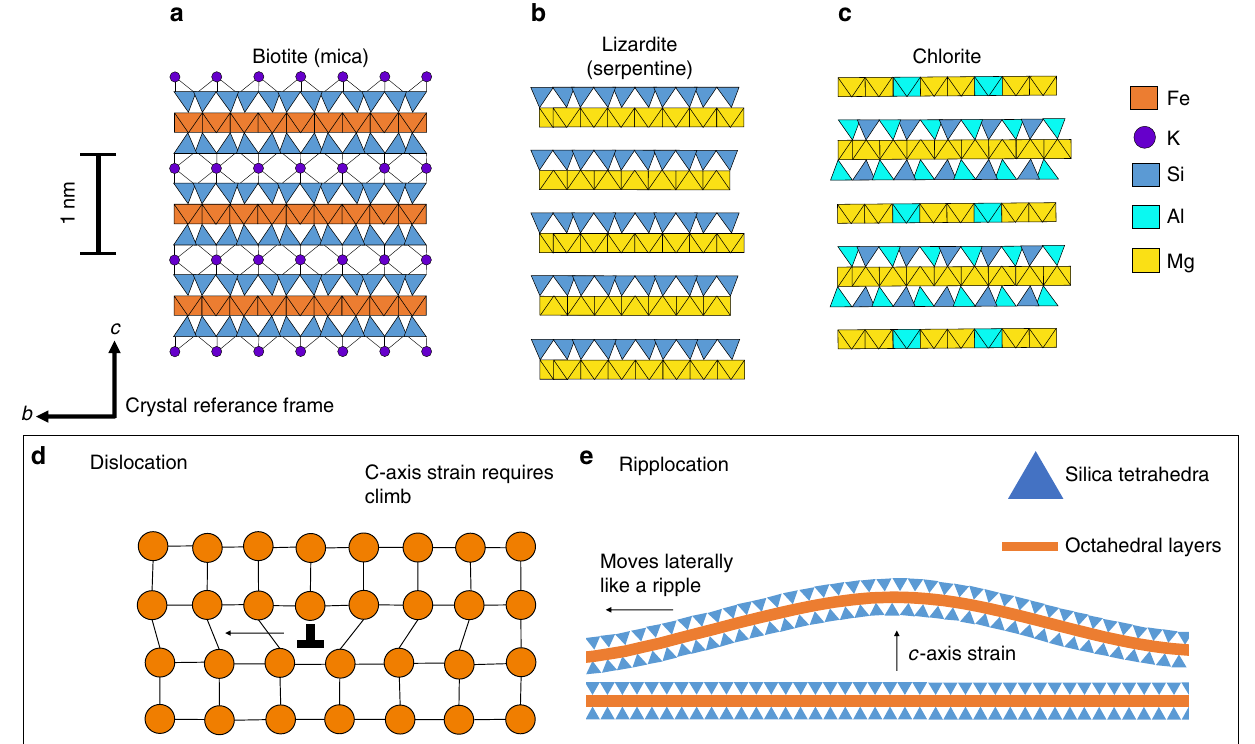
Fig. 1 Phyllosilicate structures and ripplocation morphology. a – c Atomic structure models of some common phyllosilicates with valences identi fi ed by polygons. The indices of these polygons are occupied by O atoms or OH groups. a Biotite, like other micas, requires an interlayer cation (I) to balance the overall negative charge of its tetrahedral (T) and octahedral (M) layers. In the cases of biotite and muscovite this cation is predominantly K, whereas in paragonite, and others, it is Na. b Lizardite, like the other serpentine minerals antigorite and chrysotile, has a 1:1 ratio of T to M layers, which possess a neutral charge resulting in no interlayer cations. c The structure of chlorite is similar to biotite except that the interlayer cations are replaced by individual octahedral layers, so called brucite like sheets. d , e Comparison between a dislocation ( d ) and a ripplocation in a generic phyllosilicate lattice ( e ). Both enable the movement of one plane of atoms over another. However, while dislocation climb is required to deform out of this plane in d , ripplocations intrinsically contain an element of c -axis parallel strain due to bending and more crucially are attracted to each other rather than